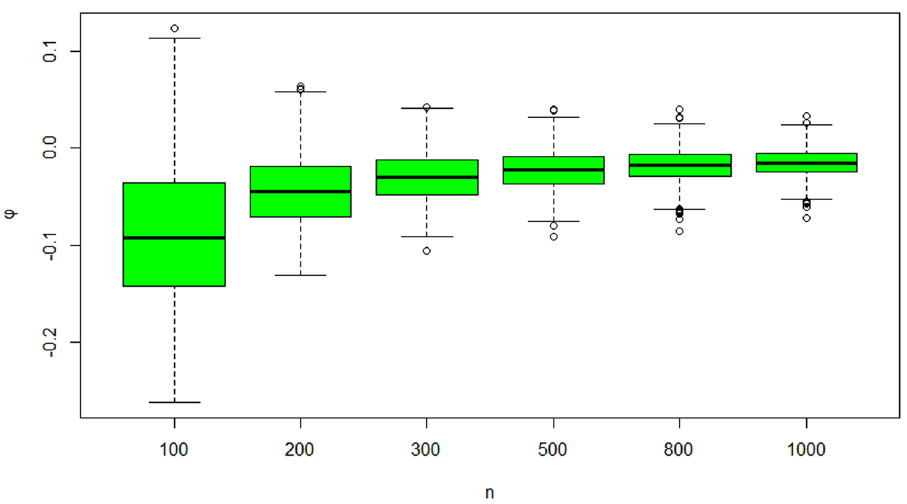
Figure 10: Boxplots